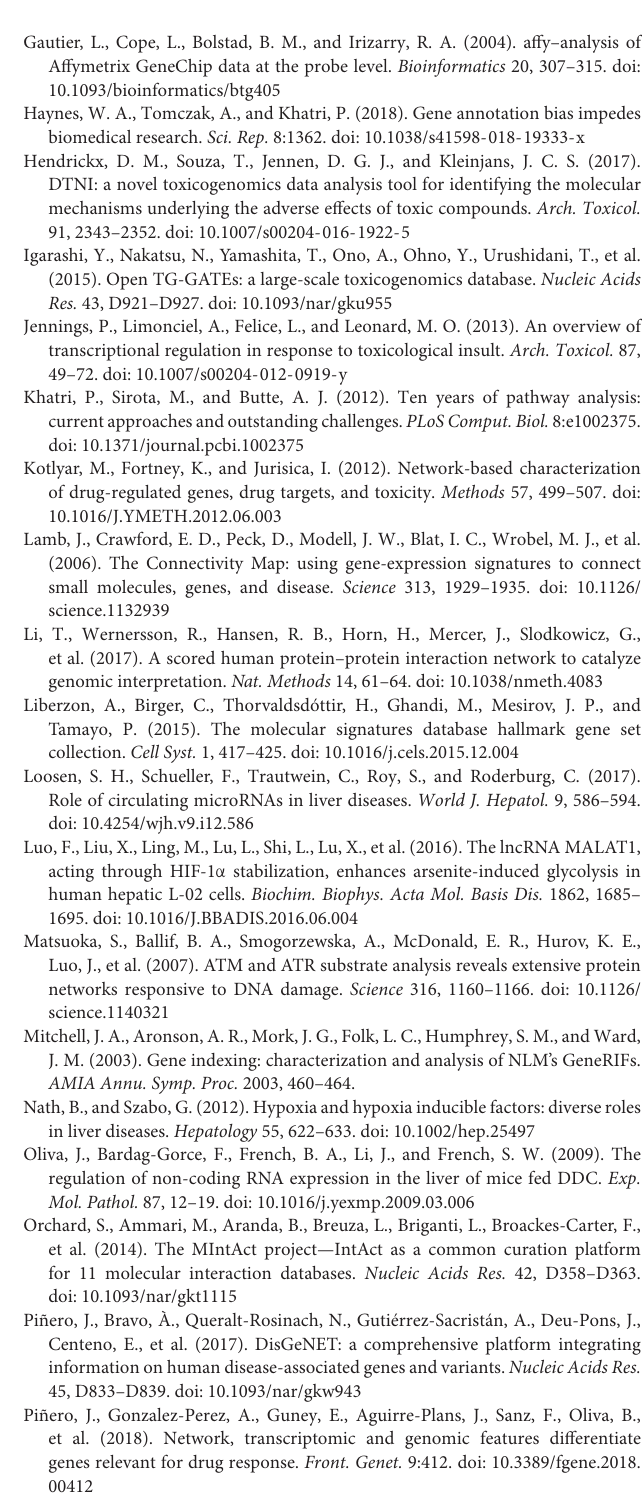
TABLE S1 | Comprehensive overview of the dark genes analyzed, including (i) modulation by individual chemicals and per DILI risk, (ii) current mapping status to gene ontology (GO) and pathways (several databases), and (iii) results obtained from different methodologies applied.